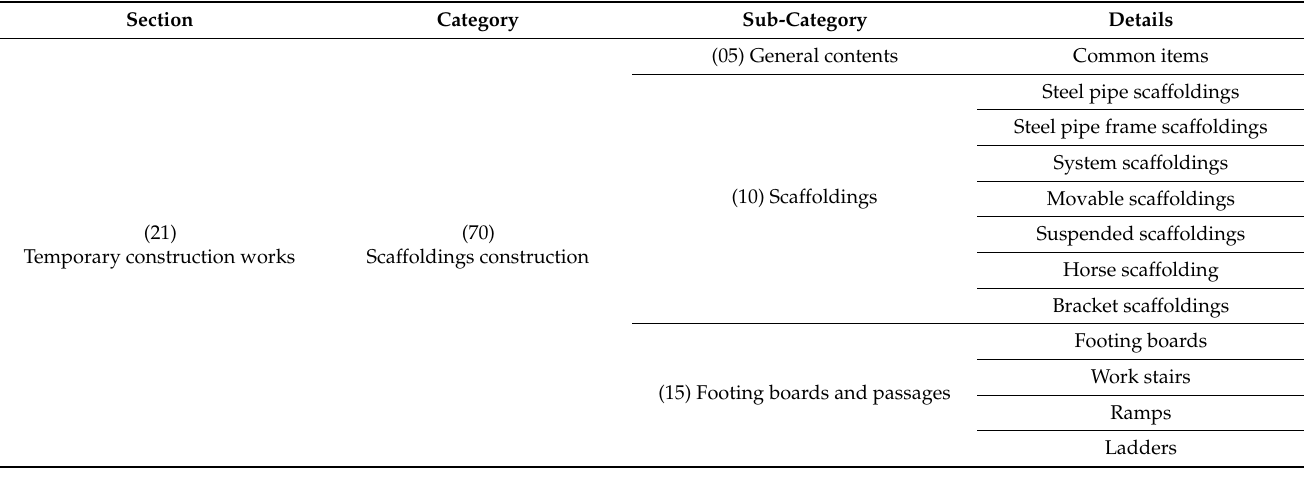
Table 1. TCW categorization system of Korean construction standard specification code